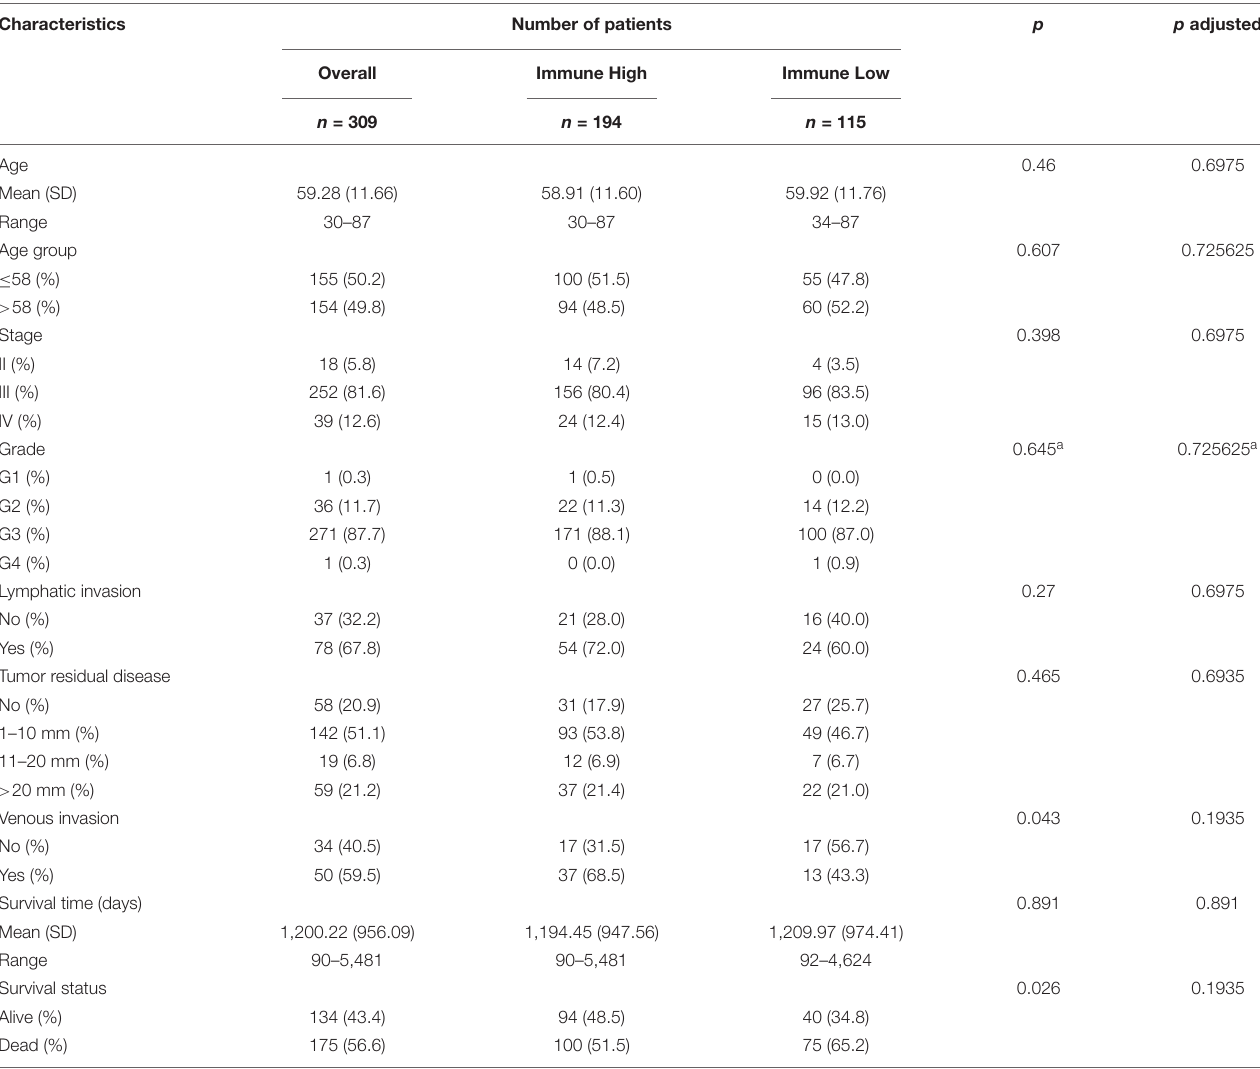
TABLE 1 | Clinical pathological characteristics of OV patients in TCGA ( n = 309).